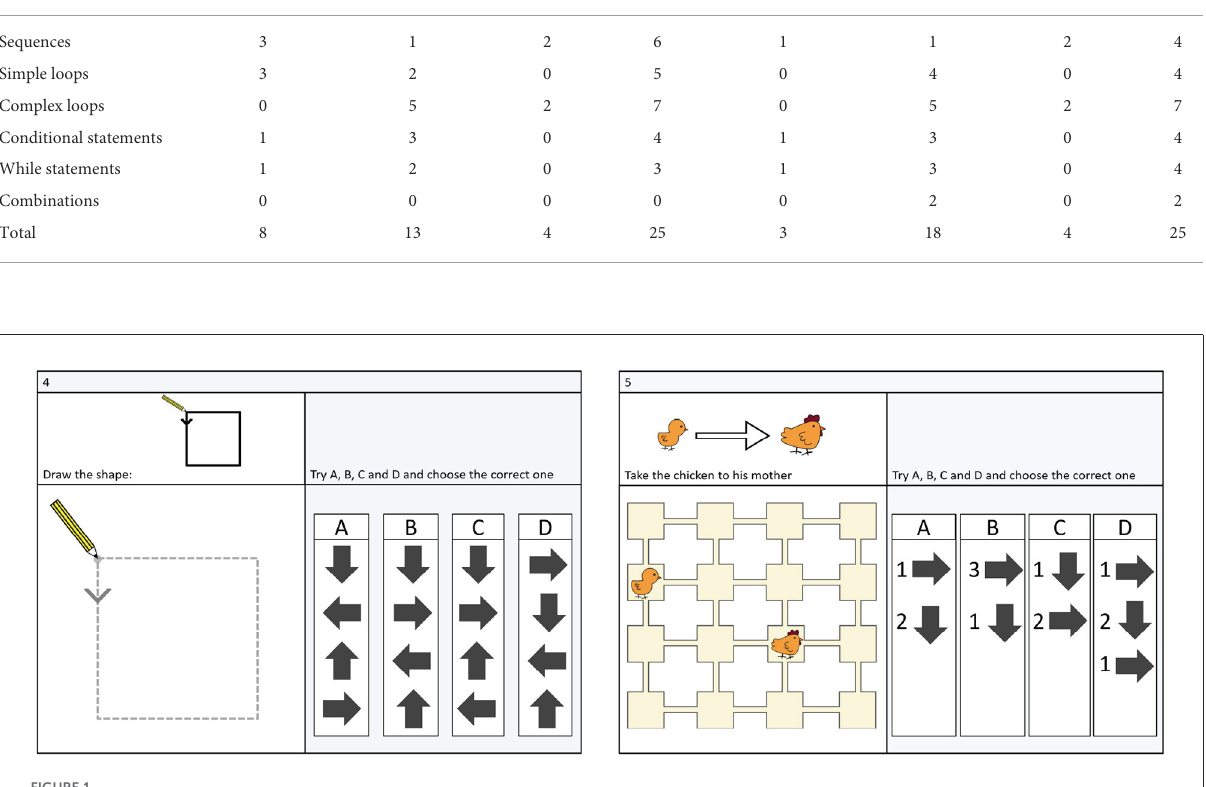
correlation above 0.15 is recommended, with good